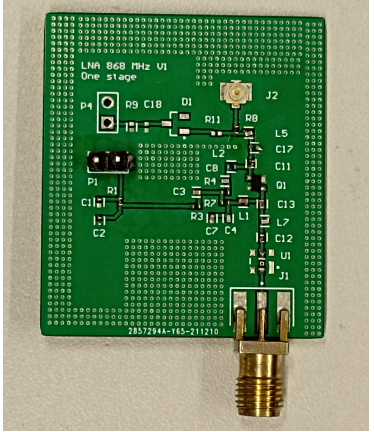
Figure 12. Assembled LNA Printed Circuit